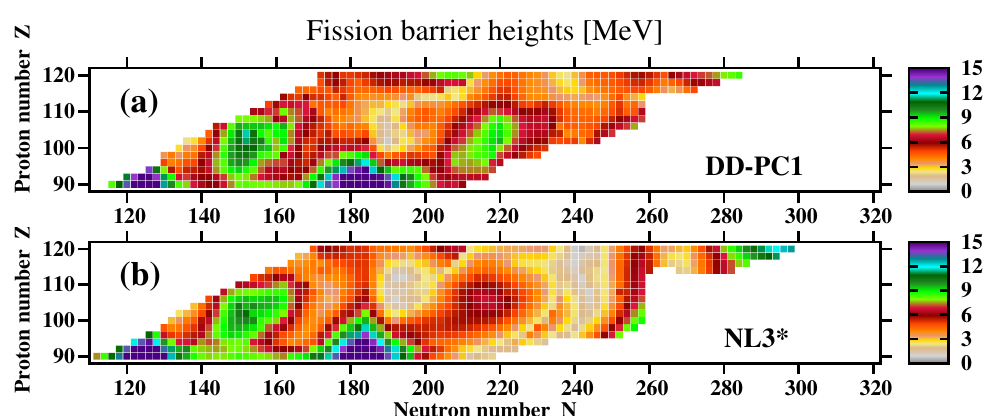
Figure 1. The heights E B (in MeV) of PFBs obtained in axial RHB calculations as a function of proton and neutron numbers for nuclei located between two-proton and two-neutron drip lines. Based on Fig. 15 of Ref.